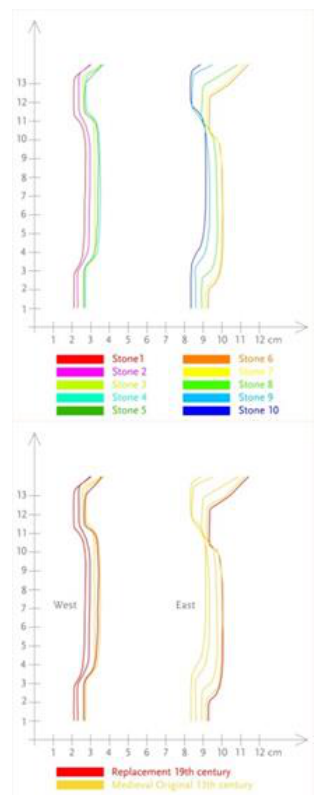
Figure 4. Average vertical cross sections of every stone (above), comparison between Middle Ages and 19 th century